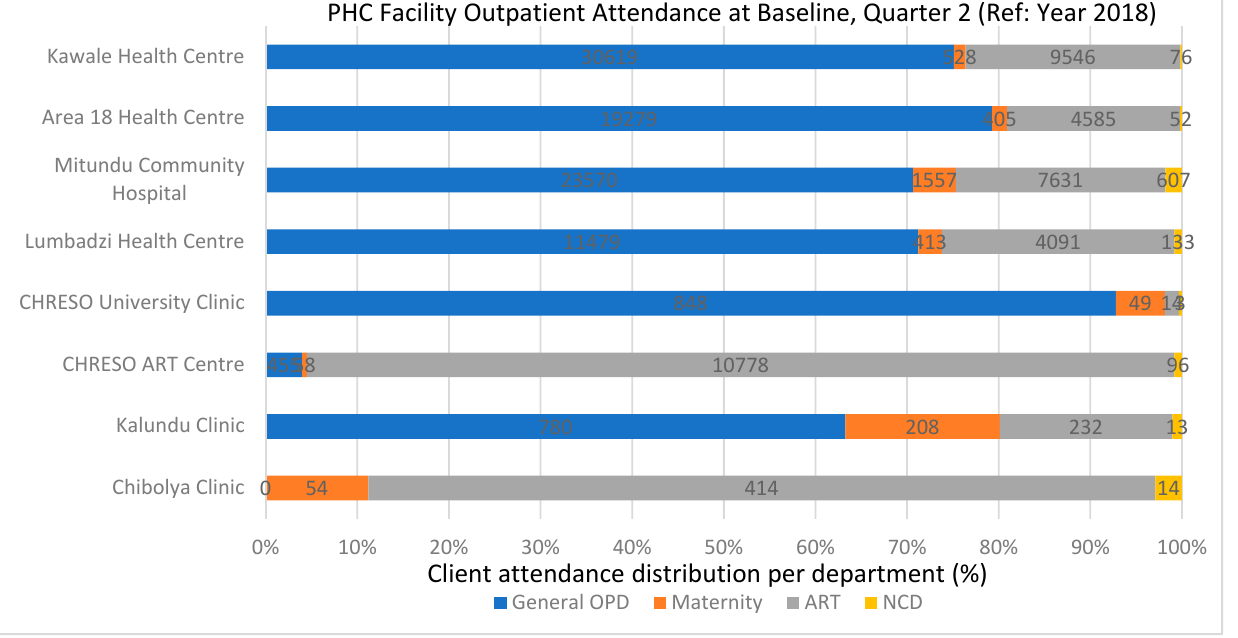
Figure A2. Reported average patient attendance per facility during second quarter 2018 (note: general outpatient department (OPD) figures exclude NCD outpatient attendance).